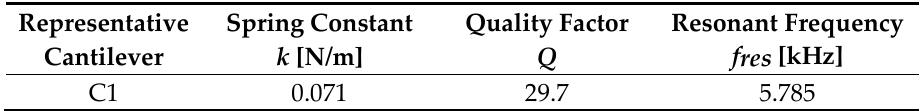
Figure 1. PF cantilever under the measurement process. ( b ) an PF cantilever array. Each cantilever is equipped with an actuating mirror (suspended) and sensing mirror at the very end. Table 1. PF cantilever array parameters. These parameters were measured from vibrations caused by the intrinsic thermal noise.